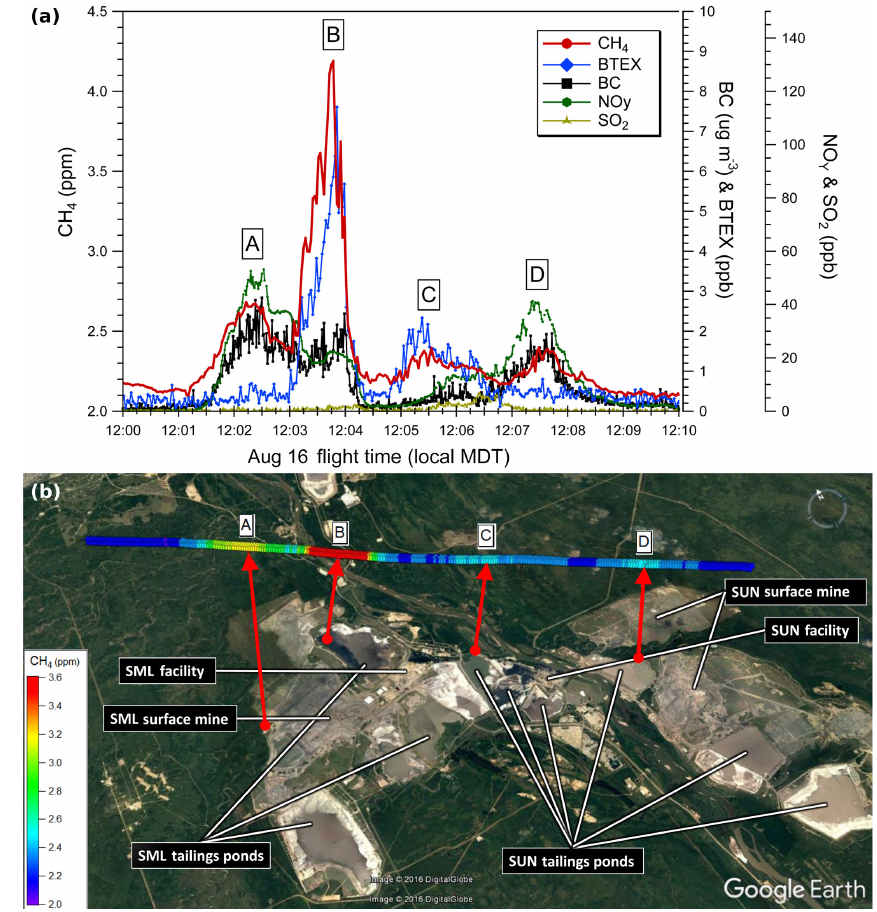
Figure 2. (a) Aircraft measurements of CH 4 (red), BTEX (blue) and r BC (black) from a single transect at 150m a.g.l. downwind of SML and SUN on 16 August. Four plumes are labeled: A (SML mine), B (SML tailings), C (SUN tailings) and D (SUN mine). (b) CH 4 mixing ratios along the 150m a.g.l. transect for the above time series. Each data point is color coded for the CH 4 mixing ratio and instantaneous wind vector measured on the aircraft at that location. Red arrows indicate air parcel back trajectories based on the linear back extrapolation of the aircraft-measured wind vectors at plume centers, with end points at 100min (A) and 20min